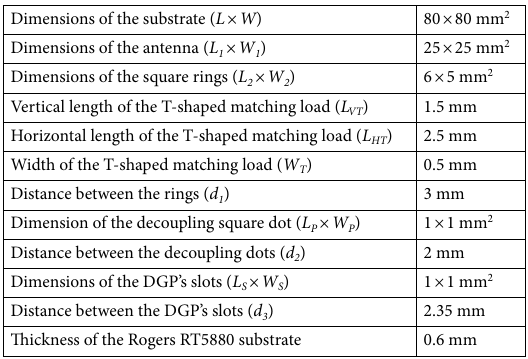
Table 1. Units for magnetic properties geometrical design parameters of the array